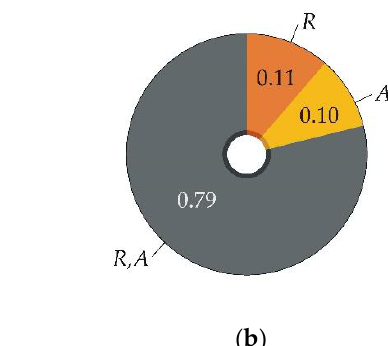
Figure 16. First- and higher-order variance-based sensitivity indices of global sensitivity analysis of P f 1 using Z ’: ( a ) Z ’ based on Equation (6); ( b ) Z ’ based on Equation (22) with c 4 = 0.079 and c 0 = 10 9 . The sensitivity ranking can be determined using total sensitivity indices [57]. The